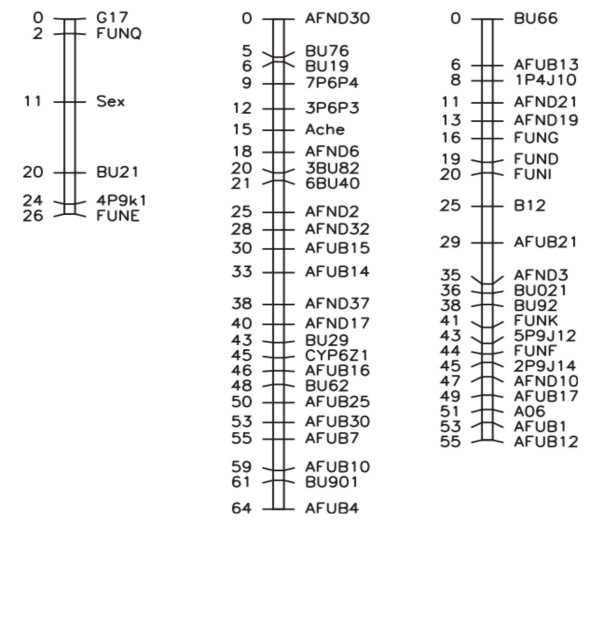
Genetic map of An. funestus using the combined data from the 11 families. A scale of genetic distance in centimorgans is shown.